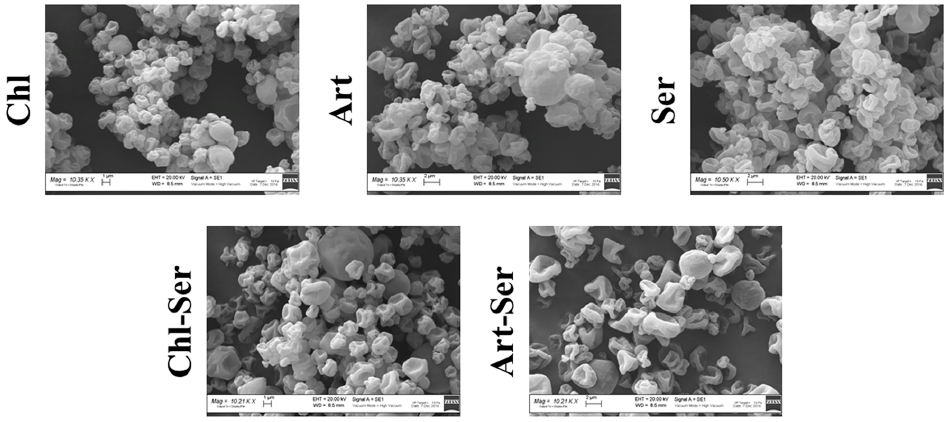
Figure 1. SEM images of Chl, Art, Ser, Chl-Ser and Art-Ser microsphere formulations; scale bar: 2 µm.